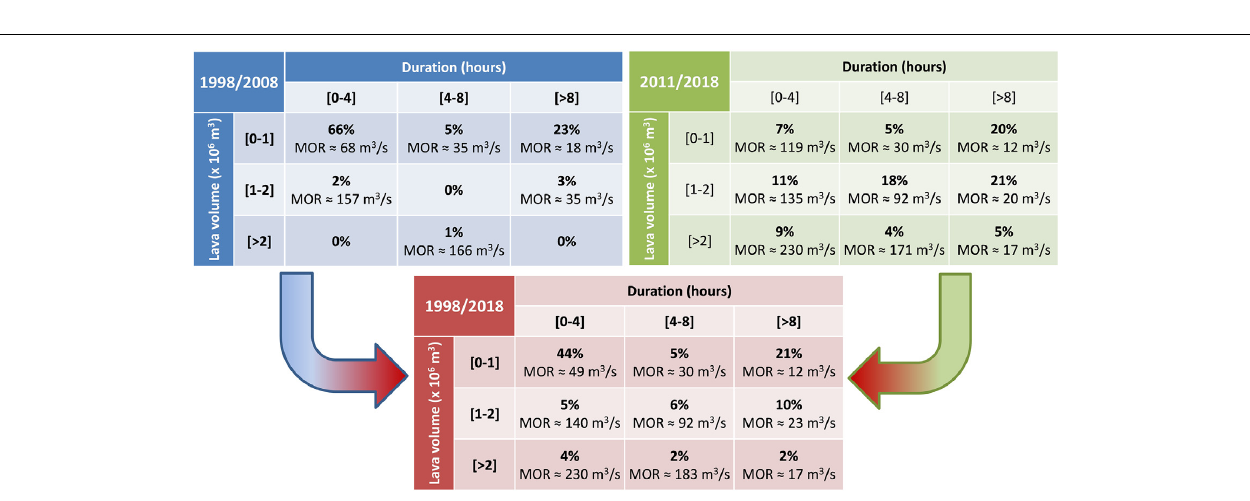
FIGURE 4 | Classification of eruptive events at SEC based on duration and lava volume by time period: from 1998 to 2008 (blue), from 2011–2018 (green), and for the entire data range (red). Each class reports the percentage of occurrence and MOR, estimated as the ratio between the median values of erupted lava and